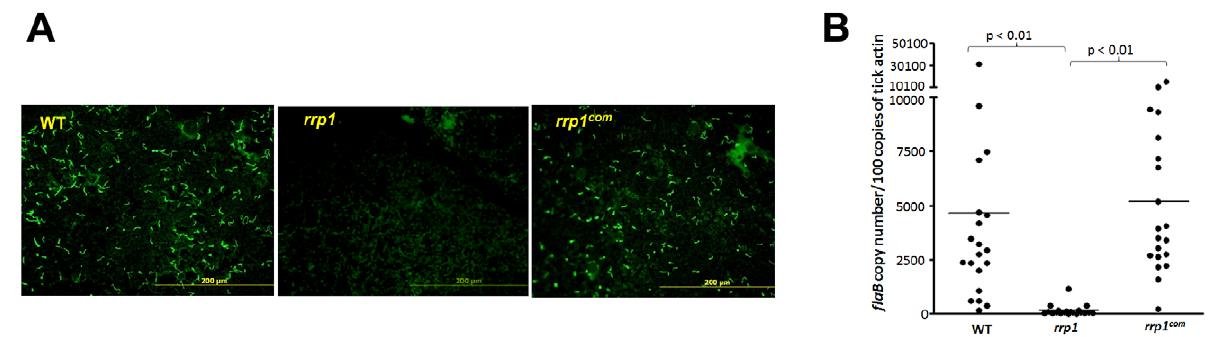
Figure 2. The rrp1 mutant failed to survive in ticks upon acquisition. ( A ) IFA analysis of spirochetes from fed larvae. I. scapularis larvae were fed on needle infected C3H/SCID mice harboring wild-type (5A4NP1), rrp1 , or rrp1 com spirochetes. Engorged larvae were collected after repletion and subjected to IFA analysis using fluorescein isothiocyanate-labeled anti- B. burgdorferi antibody. Twelve ticks were examined in each group and a representative image for each group of ticks is shown. ( B ) qPCR analyses of spirochete burden in fed larvae. Quantitative PCR for the B. burgdorferi flaB gene was performed with DNA extracted from fed larvae. Each dot represents one data point from one three larval tick (a total of 20 samples with 60 ticks examined for each group from two independent experiments). The horizontal bar represents the mean value of each group.